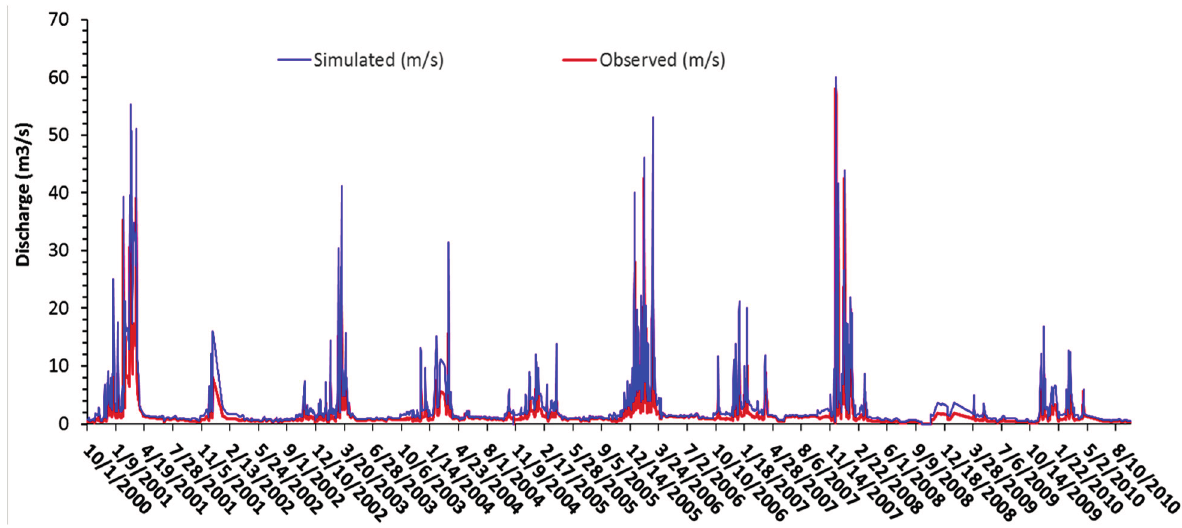
Figure 6. Observed and simulated streamflow for Marimba catchment